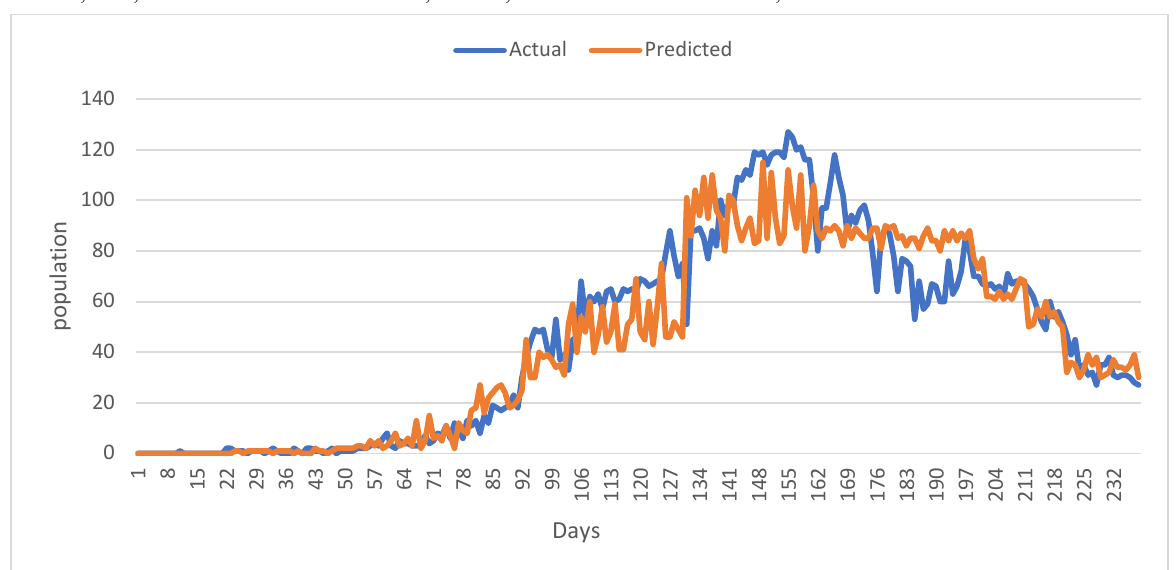
Fig. 4. Future Predicted COVID-19 Decease rate by DE